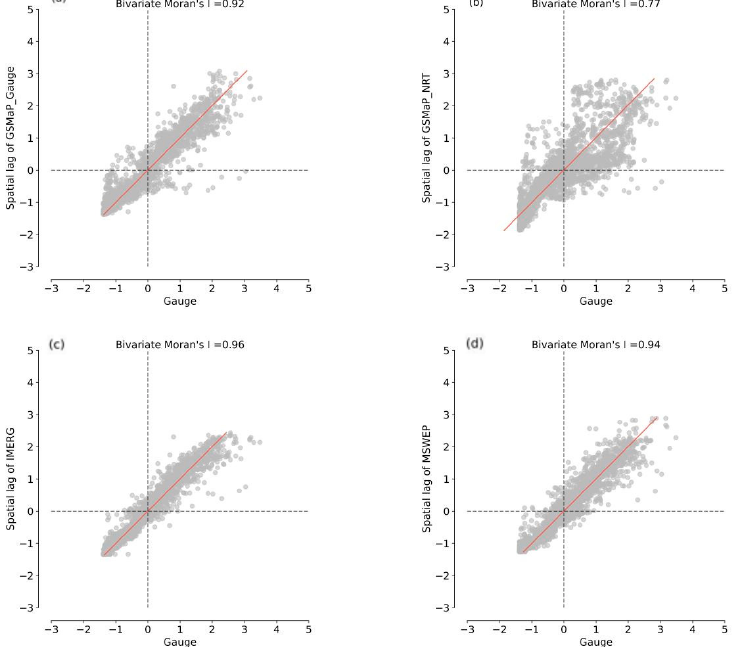
Figure 14. The global BMI sca tt er plot of R25 between the gauge observations and the four SPPs: ( a ) GSMaP_Gauge, ( b ) GSMaP_NRT, ( c ) IMERG, and ( d ) MSWEP.